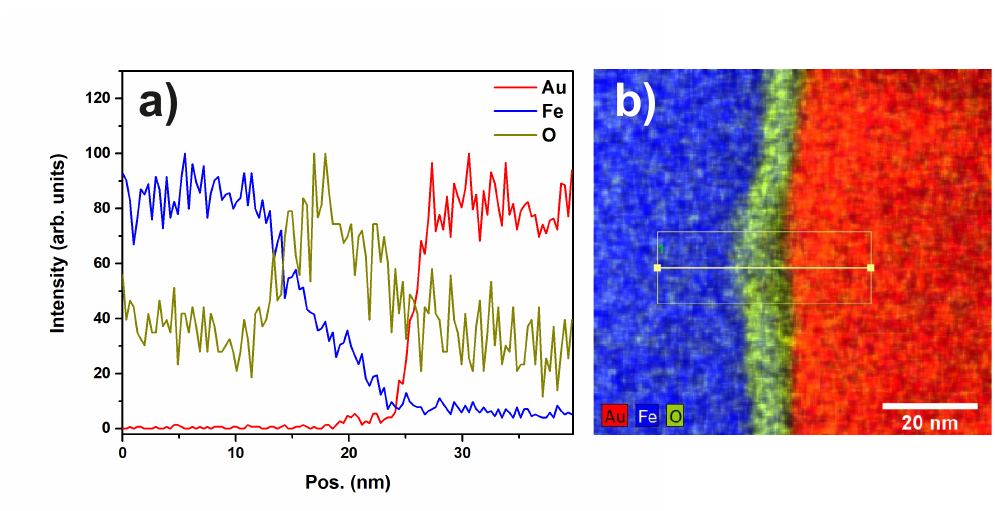
Figure 5. ( a ) EDX linescan of sample “Au” showing the intensities of the Au, Fe and O signals; ( b ) EDX mapping indicating the region from which the linescan was extracted.